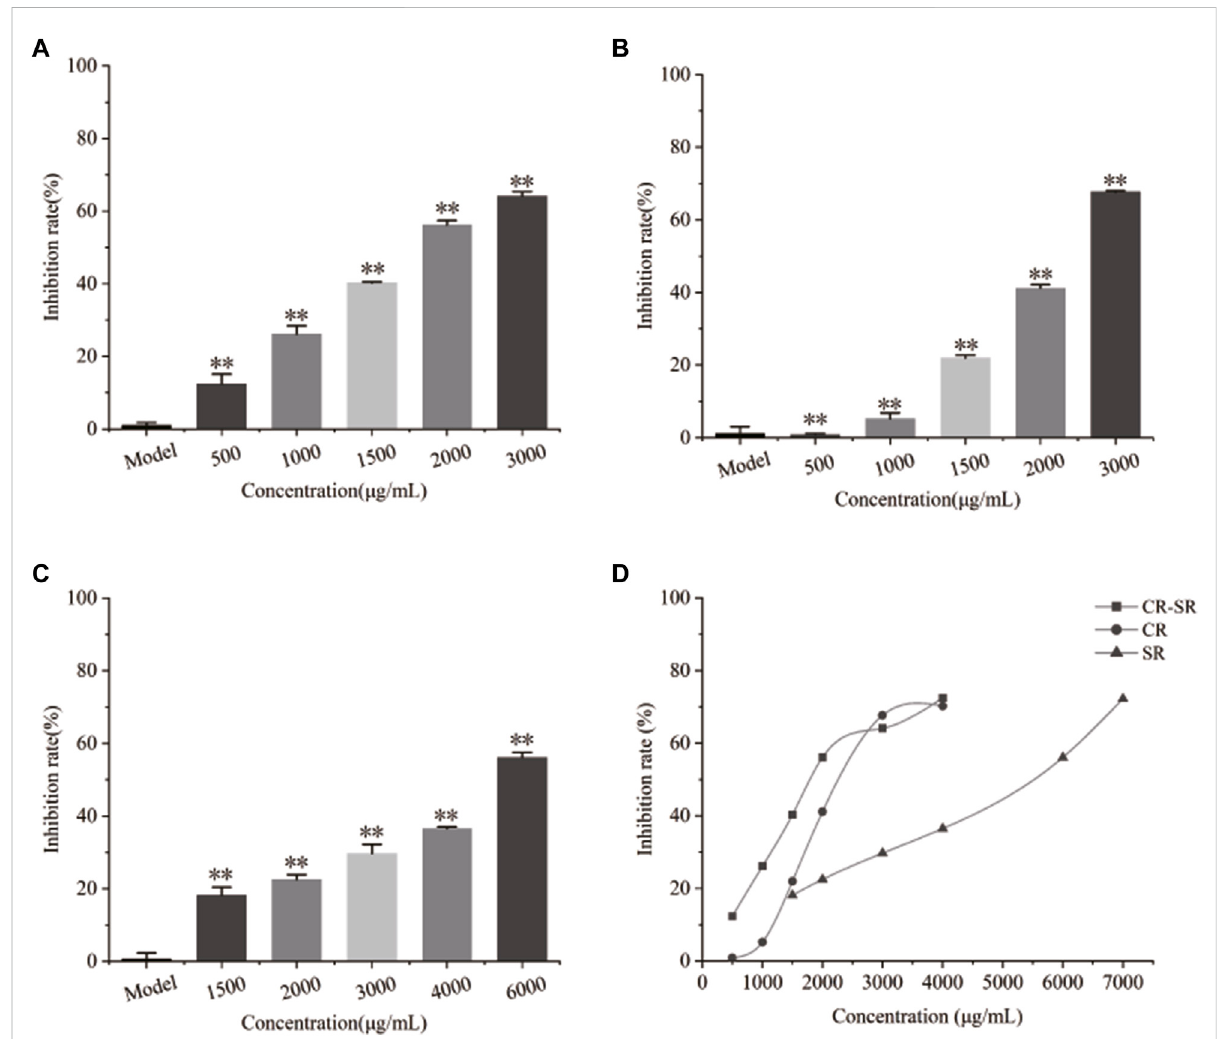
FIGURE 10 Inhibitory effects on the proliferation rate of HepG2 cells. ** p < 0.01 compared with the model group. (A) Chart of CR-SR, (B) chart of CR, (C) chart of SR, and (D) line chart of CR-SR, CR, and SR.